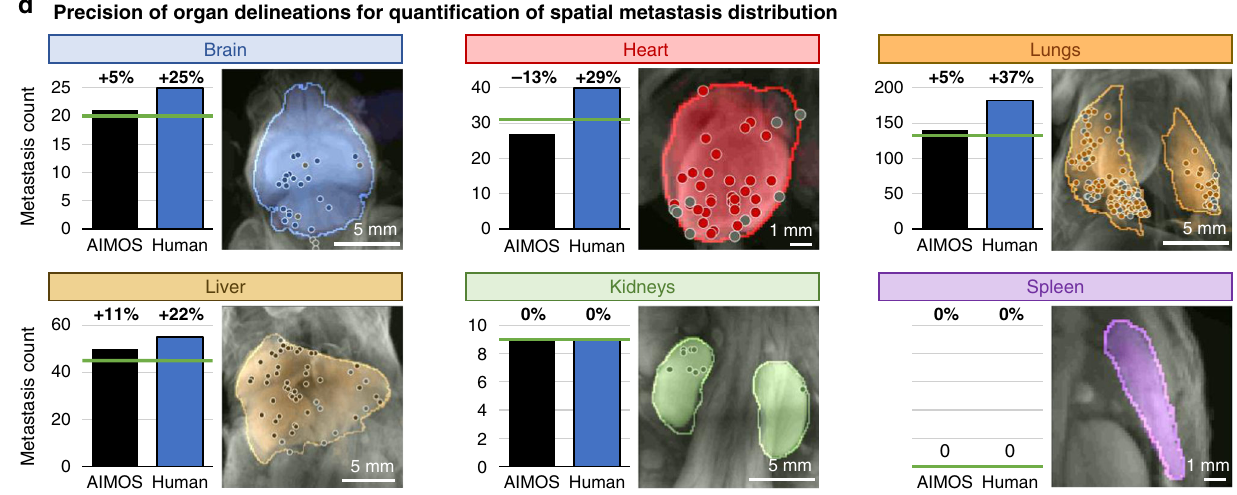
Fig. 6 AIMOS can be applied to other imaging modalities. a 3D light-sheet microscopy dataset was obtained from 15 mice at a resolution of 6 μ m/voxel. Each scan is available without staining (native) and with fl uorescent nucleus-staining with propidium-iodide (PI). b Box plots of Dice scores per organ; each box extends from lower to upper quartile values of data, with a black line at the median; whiskers extend to outmost data point within 1.5× the interquartile range; outliers beyond whiskers are shown as diamonds; each box plot represents represents n = 15 independent scans from 15 biologically independent animals. c Filled, semitransparent areas show AIMOS prediction, opaque lines indicate human expert annotation. Left column shows average intensity for whole-body scan; second column shows representative coronal slice. Right half of panel shows individual organs (coronal slice through center of organs). d Bar charts and mean-intensity projections of metastasis counts per organ, based on segmentation by AIMOS or a human expert (a detailed description of this visualization is provided in the Methods section). Location of metastases indicated with circle (diameter not to scale); metastases are shown in gray if they were incorrectly allocated to the organ based on imprecise segmentation by AIMOS or human. Green line in bar charts indicates true metastasis count. Percentage above bar charts represents relative error in metastasis count. Source data are provided as a Source Data fi